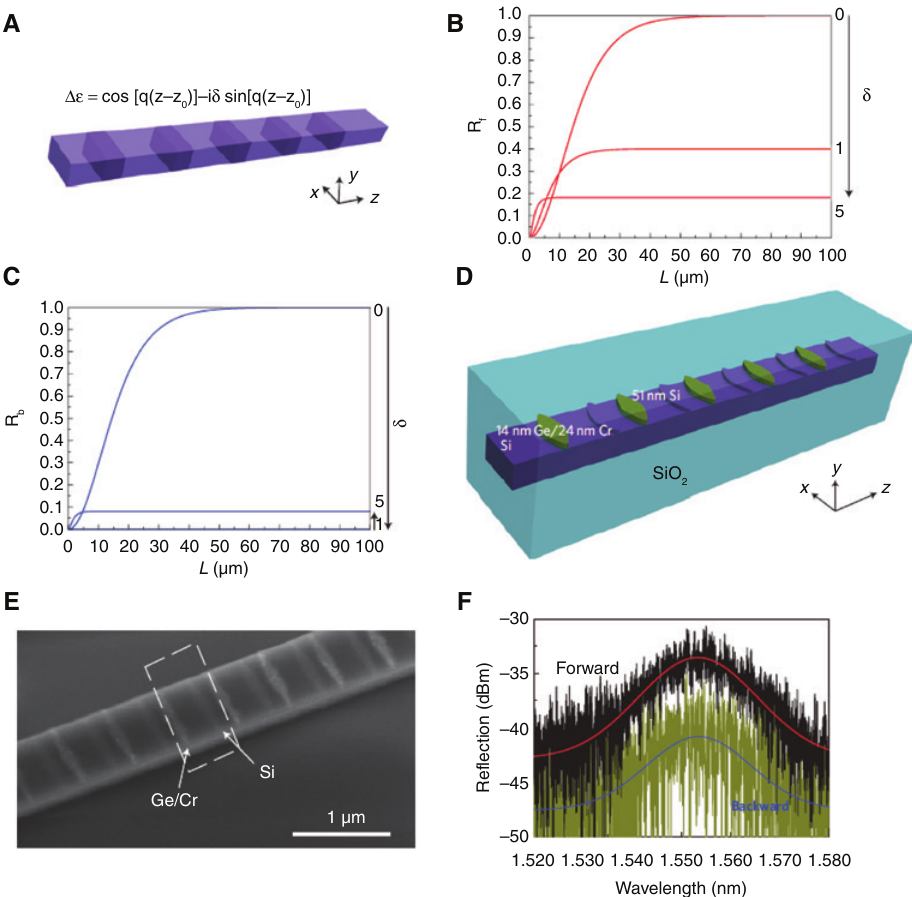
Figure 3: Optical properties of a designed passive unidirectional reflectionless PT metamaterial on an SOI platform. (A) Schematic of the passive PT metamaterial on an SOI platform. Periodically arranged PT optical potentials with modulated dielectric permittivity of Δ ε = cos( qz ) − i δ sin( qz ) (4 n π / q + π / q ≤ z ≤ 4 n π / q + 2 π / q ) are introduced into an 800-nm-wide and 220-nm-thick Si waveguide embedded in SiO . The period is 4 π / q = 575.5 nm. (B and C) Dependences of reflectance of the passive PT metamaterial on the modulation 2 length with different values of δ at the wavelength of 1550 nm in forward (B) and backward (C) directions, respectively. In contrast to the = 0 at δ = 1 and then monotonic decrease in the forward direction, reflection in the backward direction first reaches a minimum value of R b increases as δ becomes larger. (D) Periodically arranged 760-nm-wide sinusoidal-shaped combo structures are applied on top of an 800- nm-wide Si waveguide embedded inside SiO to mimic PT optical potentials, in which imaginary part modulation is implemented with 14 nm 2 Ge/24 nm Cr structures, and 51 nm Si layers are for real part modulation. The designed PT metamaterial consists of 25 sets of top-modulated combo structures with a period of 575.5 nm and a width of 143.9 nm for each sinusoidal-shaped combo. (E) SEM picture of the device, where the boxed area indicates a unit cell. (F) Measured reflection spectra of the device through the waveguide coupler for both directions over a broad band of telecom wavelengths from 1520 to 1580 nm. Red and blue curves are Gaussian fits of raw data in forward (black) and back- ward (green) directions, respectively